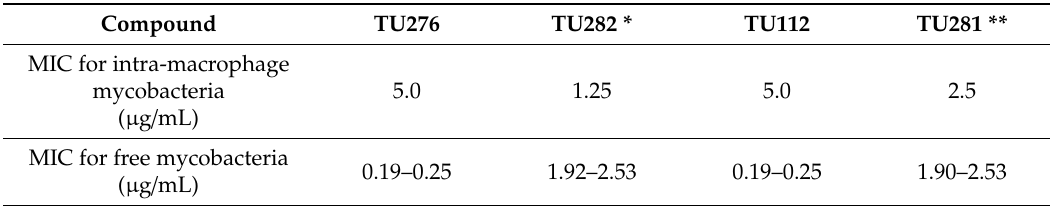
Table 3. Final dilutions of serum and lung homogenate samples providing inhibition of mycobacterial growth*.